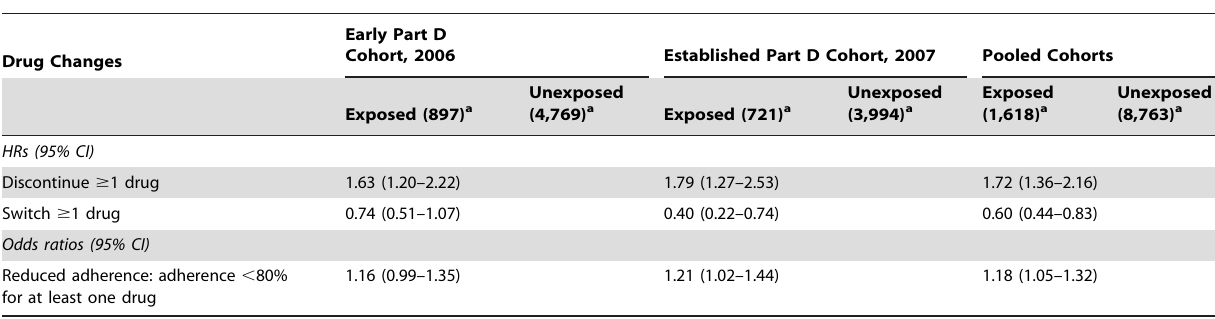
Table 4. Beneficiary-level